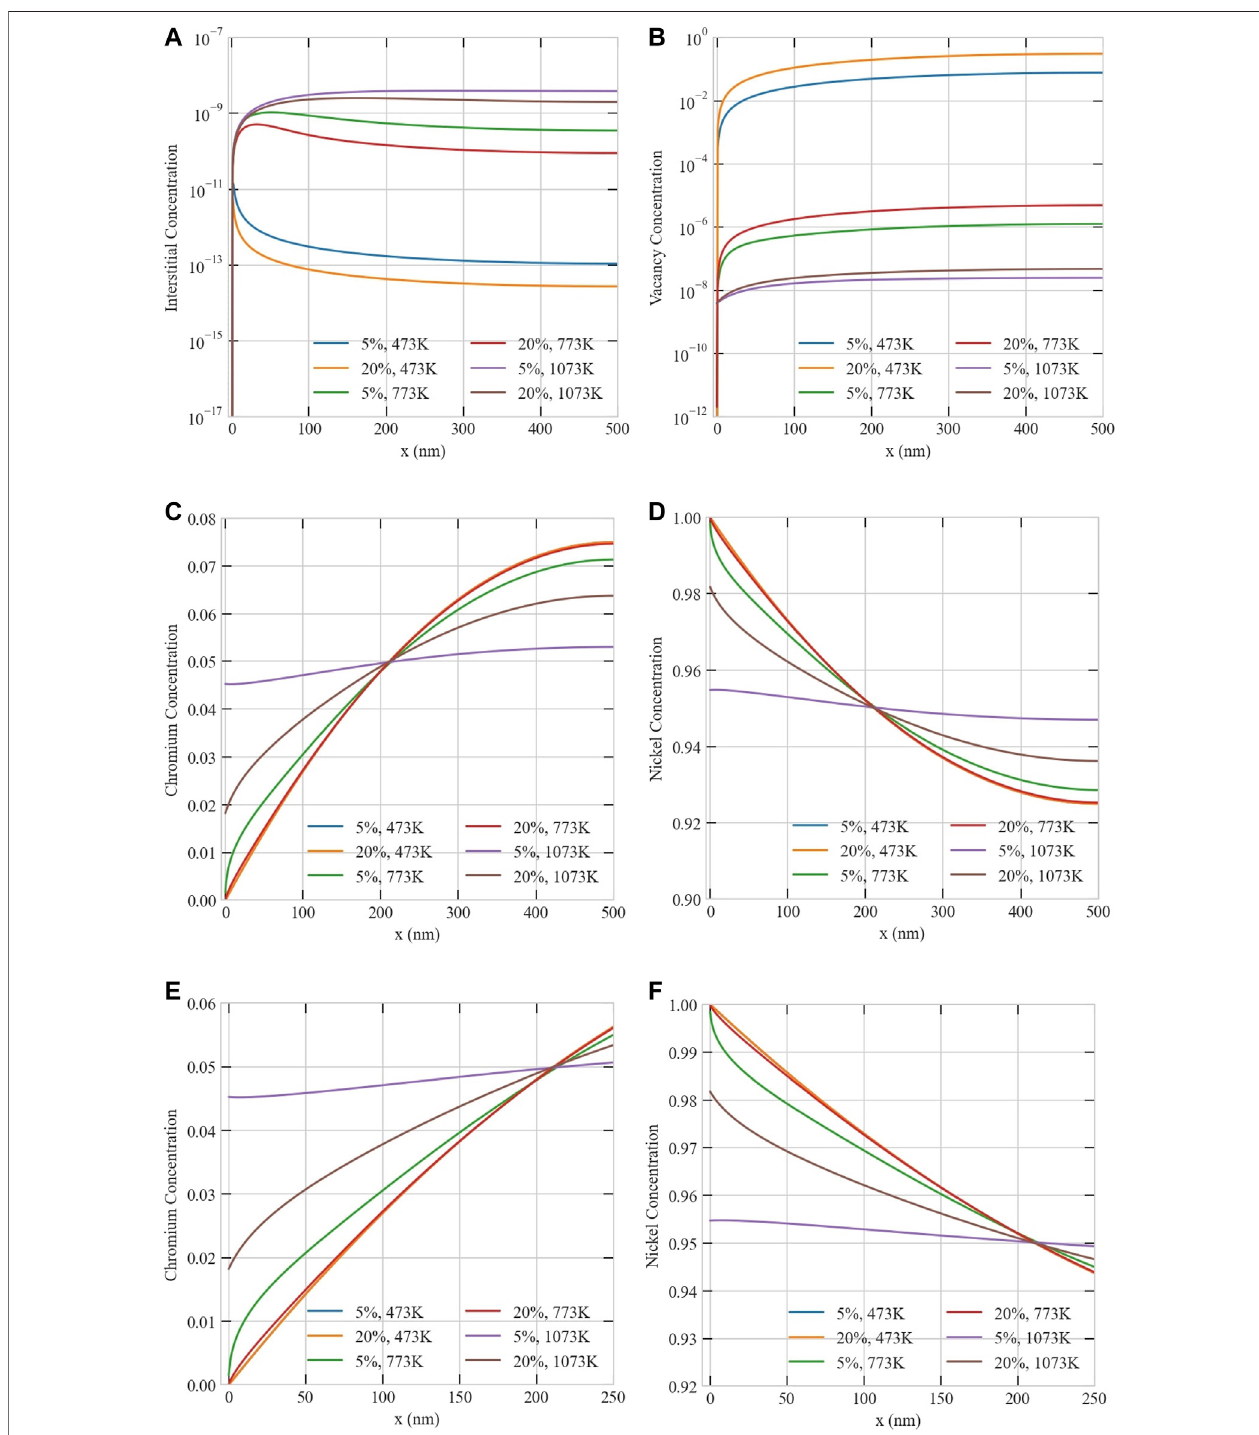
FIGURE 15 | The effect of temperature on the steady-state concentration pro fi les of defects and atoms in a 500 nm Ni-Cr grain at 1e-3 dpa/s for 5 and 20% production biases: (A) interstitials, (B) vacancies, (C) chromium atoms, (D) nickel atoms, (E) close-up for chromium atoms, and (F) close-up for nickel atoms.